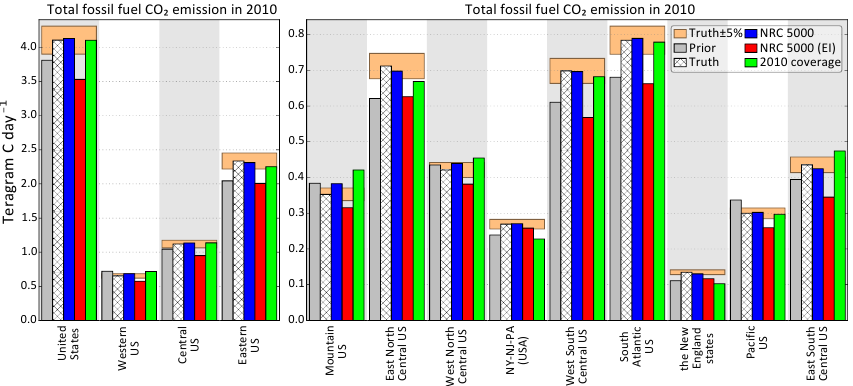
Figure 8. Annual total fossil fuel CO 2 emissions estimates for 2010 and NRC 5000 network scenarios along with true and prior fluxes aggregated for the conterminous US, individual regions and neighboring groups of regions identified in Fig. 5. The orange rectangles denote the ± 5% range around the true emission each